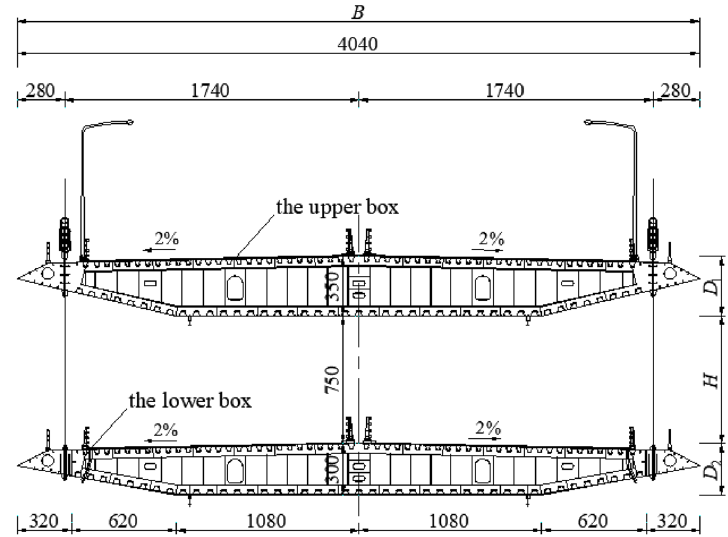
Fig. 1 Cross section of the double-deck box girder (unit: cm)